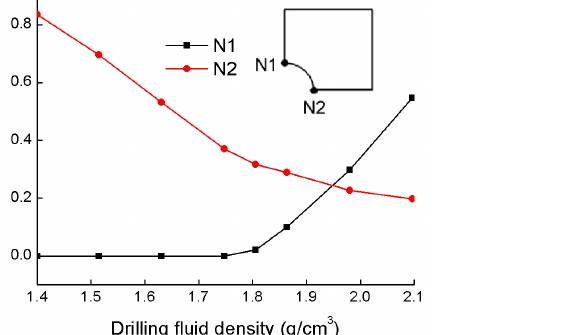
Figure 11: The value of damage at different drilling fluid density.